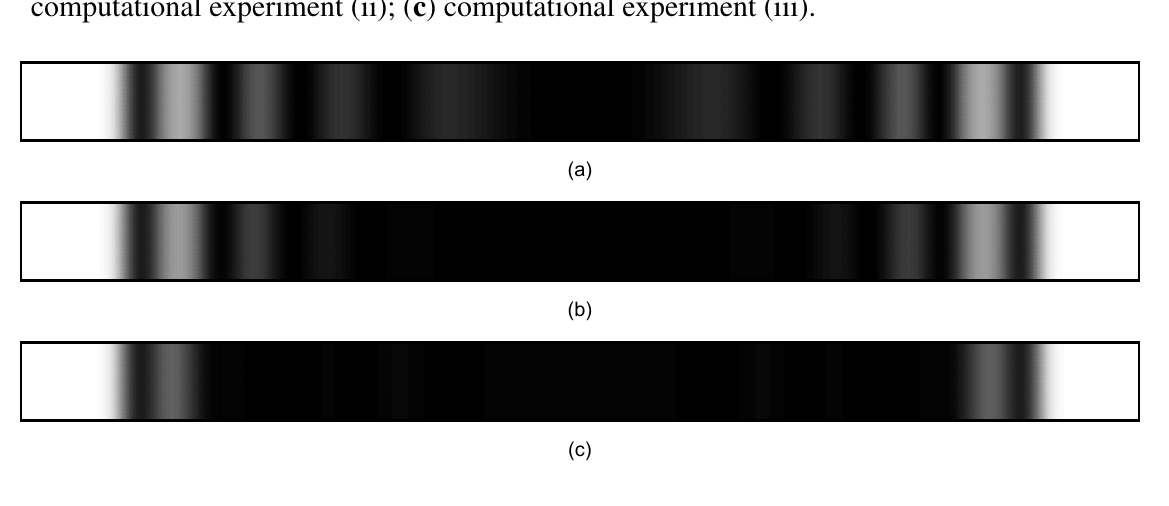
Figure 7. The formation of interference fringes for: ( a ) computational experiment (i); ( b ) computational experiment (ii); ( c ) computational experiment